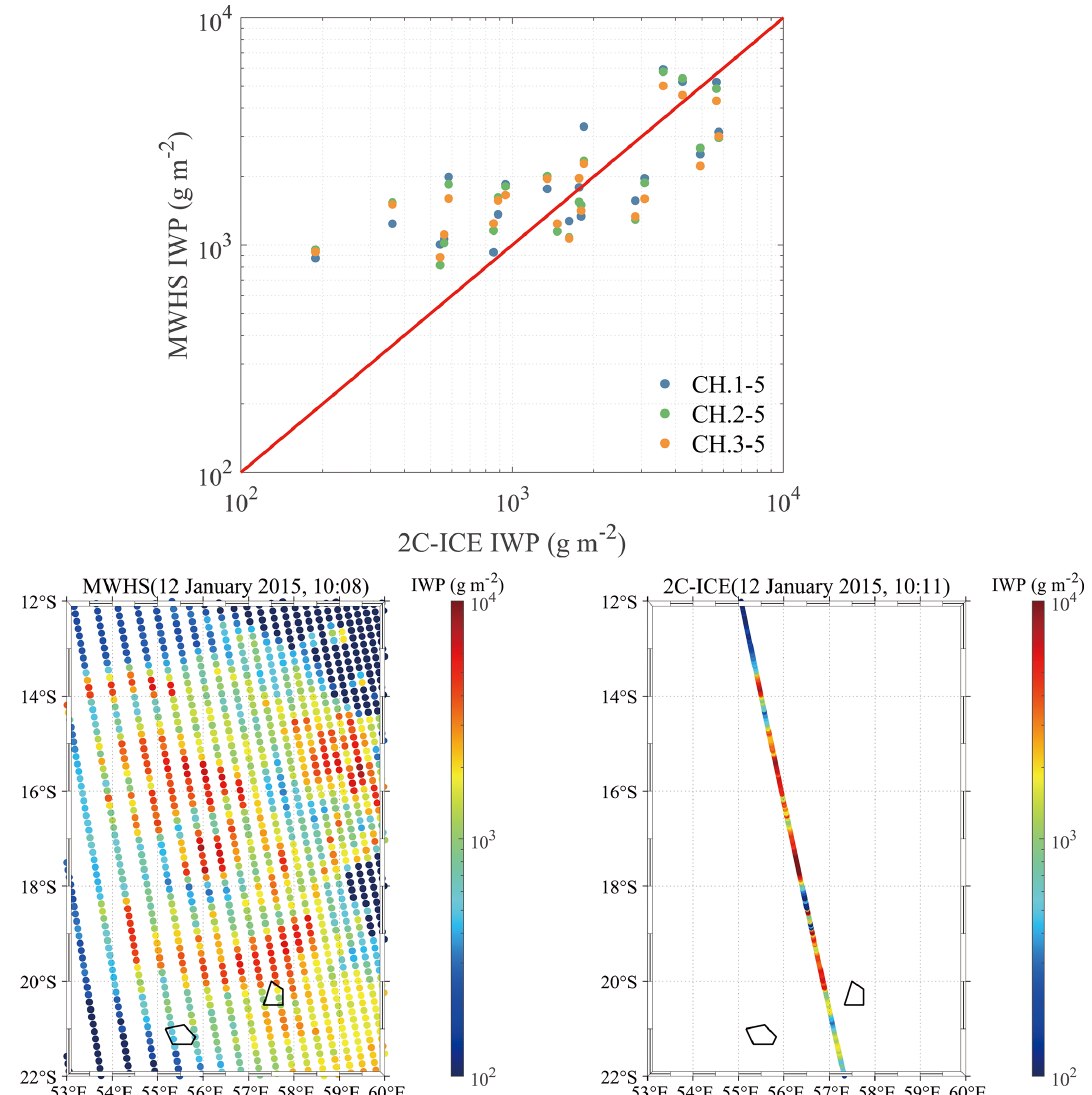
Figure 12. IWP comparison of MWHS and 2C-ICE for Tropical Cyclone